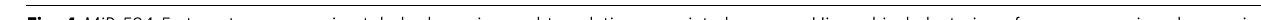
Fig. 4 MiR-584-5p targets cancer, microtubule dynamics, and translation-associated genes. a Hierarchical clustering of gene expression changes in D425Med and D458Med cells treated with miR-NC or miR-584-5p mimic for 48 h. Data are z -transformed. The cutoff criteria for each gene are fold change > 2, sample intensity > 10, and p -value < 0.05. b Gene set enrichment analysis (GSEA) showing enriched biological processes in miR-584-5p mimic- treated MB cells. c qPCR analysis of eIF4E3 and HDAC1 expression in MB cells (D556Med, D425Med, D458Med, and DAOY) transfected with miR-NC or miR-584-5p mimic. The p -values were calculated using standard Student t -tests. Error bars represent mean ± SEM of three independent experiments (performed in triplicate for each experiment). d Western blot analysis of target genes in miR-NC or miR-584-5p mimic-transfected D556Med, D425Med, D458Med, and DAOY cells. Gel photographs are representative of at least three independent experiments. e Left, luciferase-eIF4E3/HDAC1 3 ′ -UTR constructs. Inset boxes show miR-584-5p -binding sites in 3 ’ -UTRs of eIF4E3 and HDAC1 (wild type). Also shown is miR-584-5p seed sequence mutated sequences. Right, relative luciferase activity in HEK293 cells transfected with miR-NC, miR-584-5p , or miR-584-5p -binding site mutant (mut). Values were normalized to fi re fl y luciferase, which served as an internal control. The p -values were calculated using standard Student t -tests. Error bars represent mean ± SEM of three independent experiments. **** p < 0.0001; *** p <